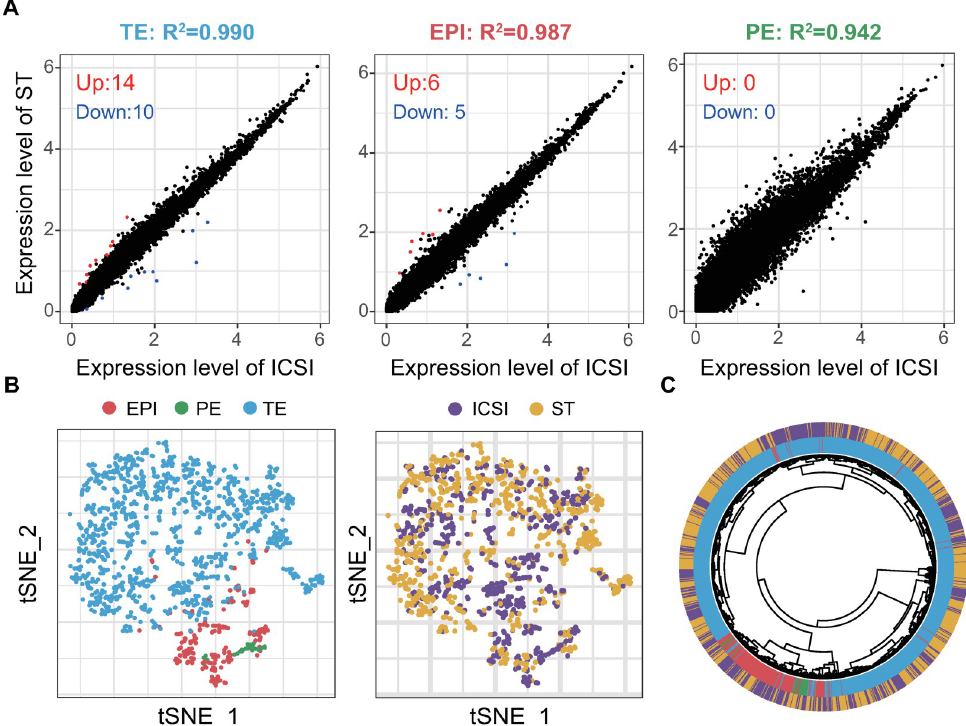
Fig 3. Comparative analysis of ST and ICSI control embryos. (A) Analysis of DEGs and linear regression analysis of ST and ICSI embryos. The ST-to-ICSI ratio of the mean expression level (ln(TPM/10+1)) for each commonly expressed gene was fitted to y~x. The correlation coefficient of each fitting and the number of up-regulated (red) or down-regulated (blue) DEGs are listed for each lineage. (B) ST and ICSI embryonic cells projected onto a t-SNE map of AUC scores from SCENIC analysis and colored according to lineage (left) and group (right). (C) Hierarchical clustering of AUC scores from SCENIC analysis. Cells of the same lineage (red, EPI; green, PE; blue, TE) clustered together. EPI and PE cells belonged to the same branch and converged to the root with TE branches. ST (yellow) and ICSI (purple) clustered together regardless of cell lineage. The numerical data are listed in S2 Data. DEG, differentially expressed gene; EPI, epiblast; ICSI, intracytoplasmic sperm injection; PE, primitive endoderm; SCENIC, single-cell regulatory network inference and clustering; ST, spindle transfer; TE, trophectoderm; t-SNE, t-distributed stochastic neighbor embedding.